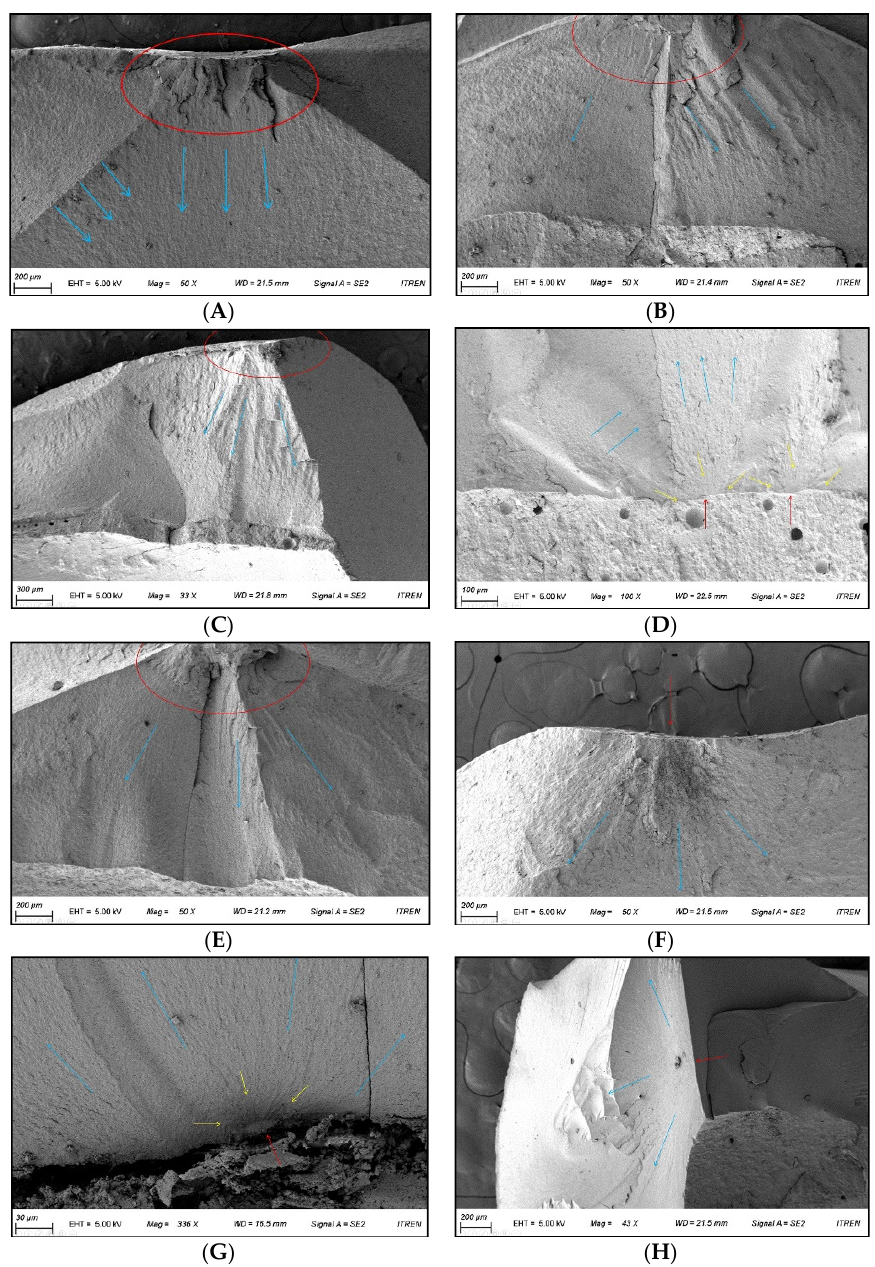
Figure 7. SEM image of crowns in tooth and titanium abutments corresponding to the area of crack origin. ( A ): Representative crown from group LS_TO (50× magnification). ( B ): Representative crown from group PICN_TO (50× magnification). ( C ): Representative crown from group RNC_TO (33× magnification). ( D ): Representative crown from group ZLS_TO (100× magnification). ( E ): Repre- sentative crown from group LS_TI (50× magnification). ( F ): Representative crown from group PICN_TI (50× magnification). ( G ): Representative crown from group RNC_TI (336× magnification). ( H ): Representative crown from group ZLS_TI (43× magnification). Red arrows and circles indicate the origin; yellow arrows refer to the ‘fracture mirror’; blue arrows refer to the ‘hackle’.